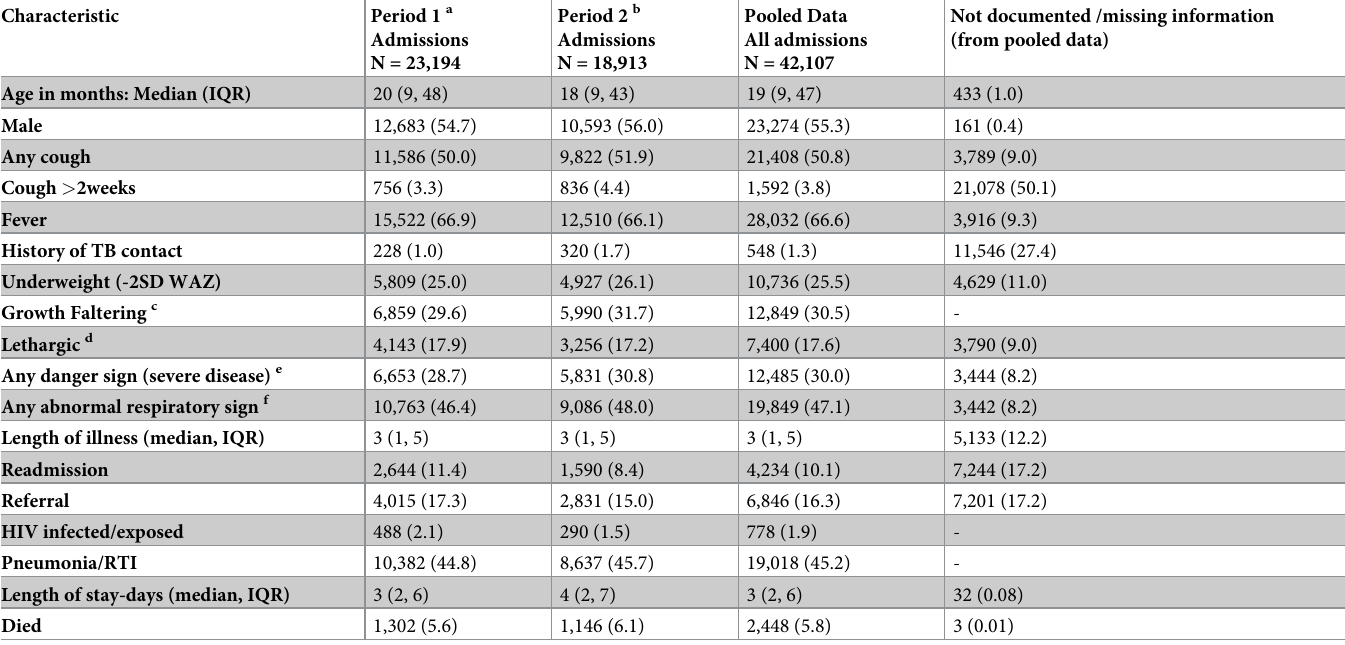
Table 2. Descriptive characteristics of patients admitted to CIN hospitals in the study